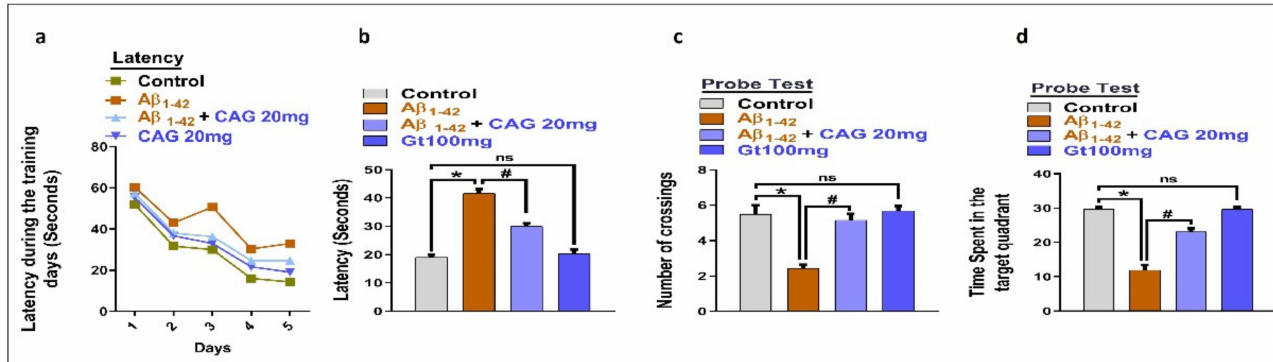
Figure 5. Effects of cycloastragenol against memory dysfunction in A β -injected mice. ( a ) Graph showing the latency to reach the platform during the training days. ( b ) Latency on day 6 after the completion of training. ( c ) Probe test, number of crossings of the platform. ( d ) Time spent in the target quadrant. The p -value < 0.05 was considered a significant difference. * showing a significant difference from the control group; # significantly different from the A β -injected group. Significance = * p < 0.05; # p < 0.05. CAG 20: Cycloastragenol 20 mg/kg, A β : Amyloid beta, CAG: cycloastragenol, ns: non-significant